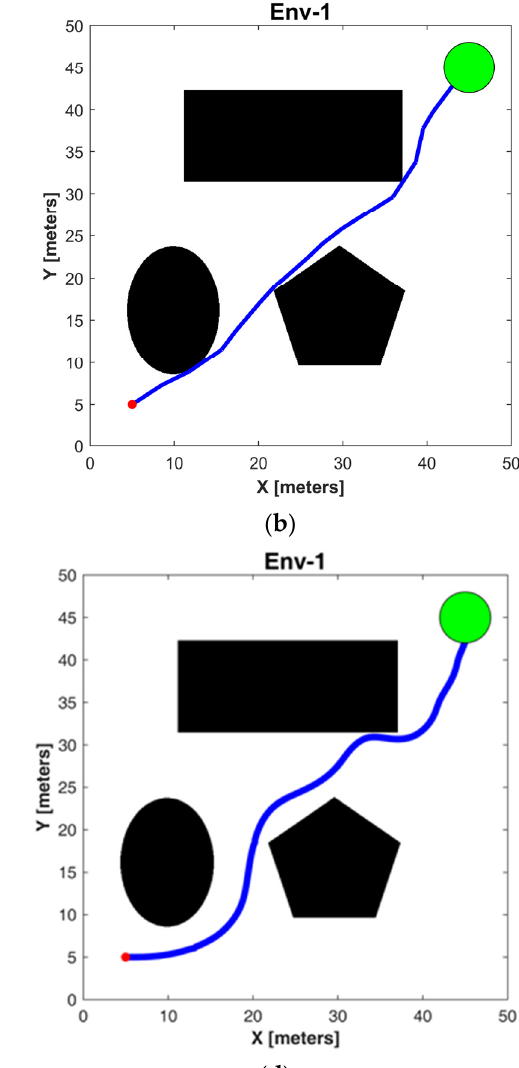
Table 2. Path characteristic parameters under scenario 1.